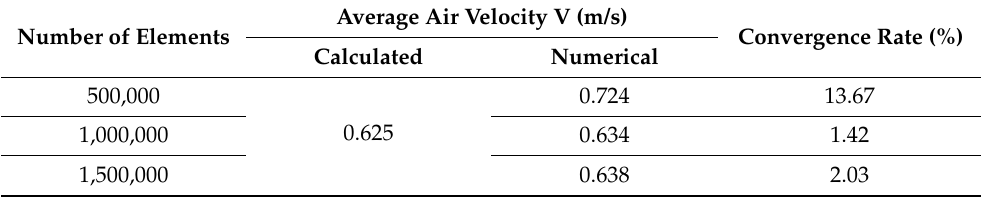
Table 3. Grid independence test.